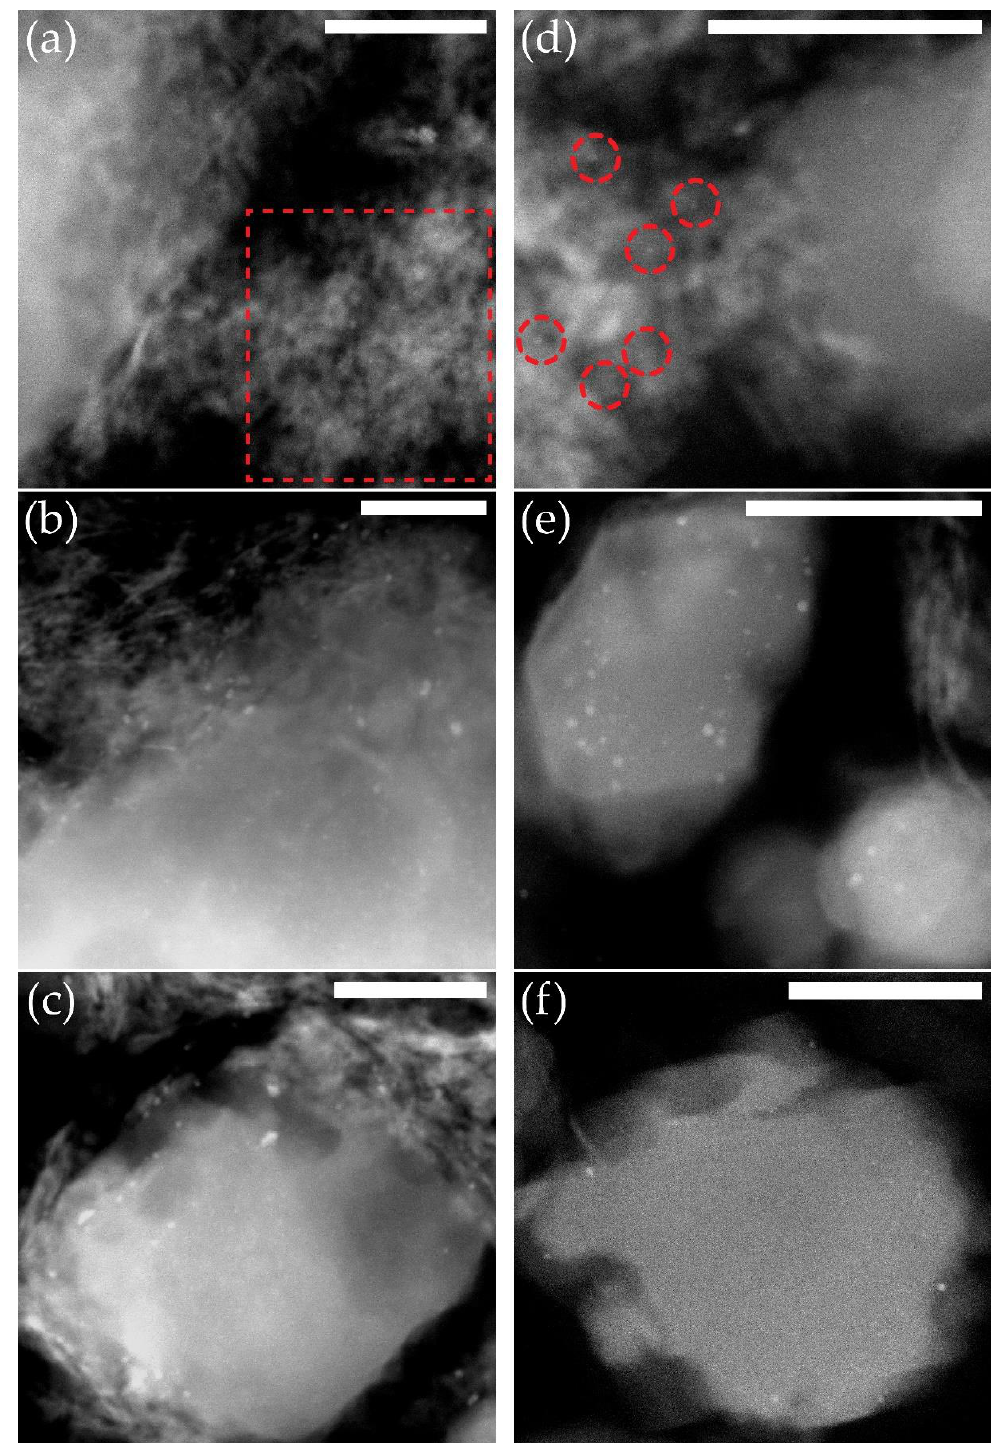
Figure 2. HAADF-STEM images of ultramicrotomed (thickness of 70 nm) catalyst samples: ( a ) Pd- γ -Al 2 O 3 /SAPO-11, ( b ) Pd-SAPO-11/ γ -Al 2 O 3 CR, ( c ) Pd-SAPO-11/ γ -Al 2 O 3 DR, ( d ) Pd- γ -Al 2 O 3 /ZSM-22, ( e ) Pd-ZSM-22/ γ -Al 2 O 3 CR, with cross sections of ZSM-22 crystals, ( f ) Pd-ZSM-22/ γ -Al 2 O 3 DR with cross sections of ZSM-22 crystals. Scalebars are 50 nm, red square and circles serve as guide to the eye towards Pd